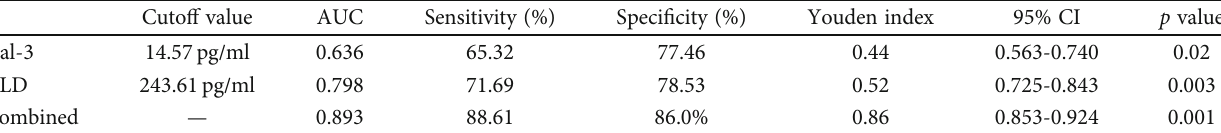
Table 3: ROC analysis of preoperative Gal-3 and ALD levels for AF recurrence after RFCA.